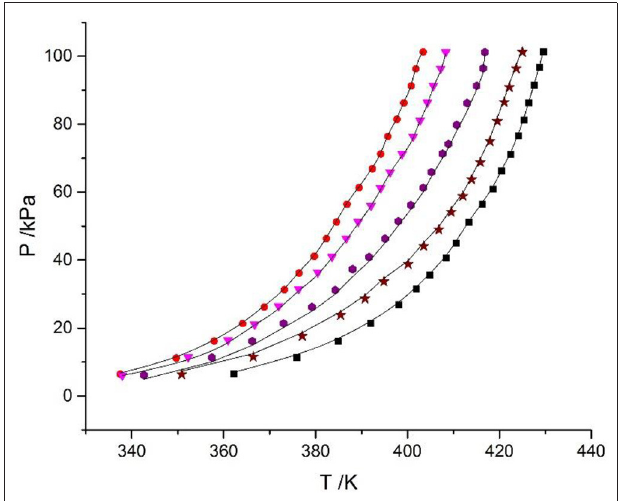
FIGURE 6 | Correlation of experimental VLE data for the LiBr + CaCl 2 + H 2 O system. Symbols ( , ma = 21.05 mol/kg, mb = 0 mol/kg; , ma = 1.5 mol/kg, mb = 8.5 mol/kg; , ma = 4.12 mol/kg, mb = 7.1 mol/kg; , ma = 11 mol/kg, mb = 3.3 mol/kg; , ma = 16.5 mol/kg, mb = 1.5 mol/kg): experimental data (this work); lines: correlation of the model.